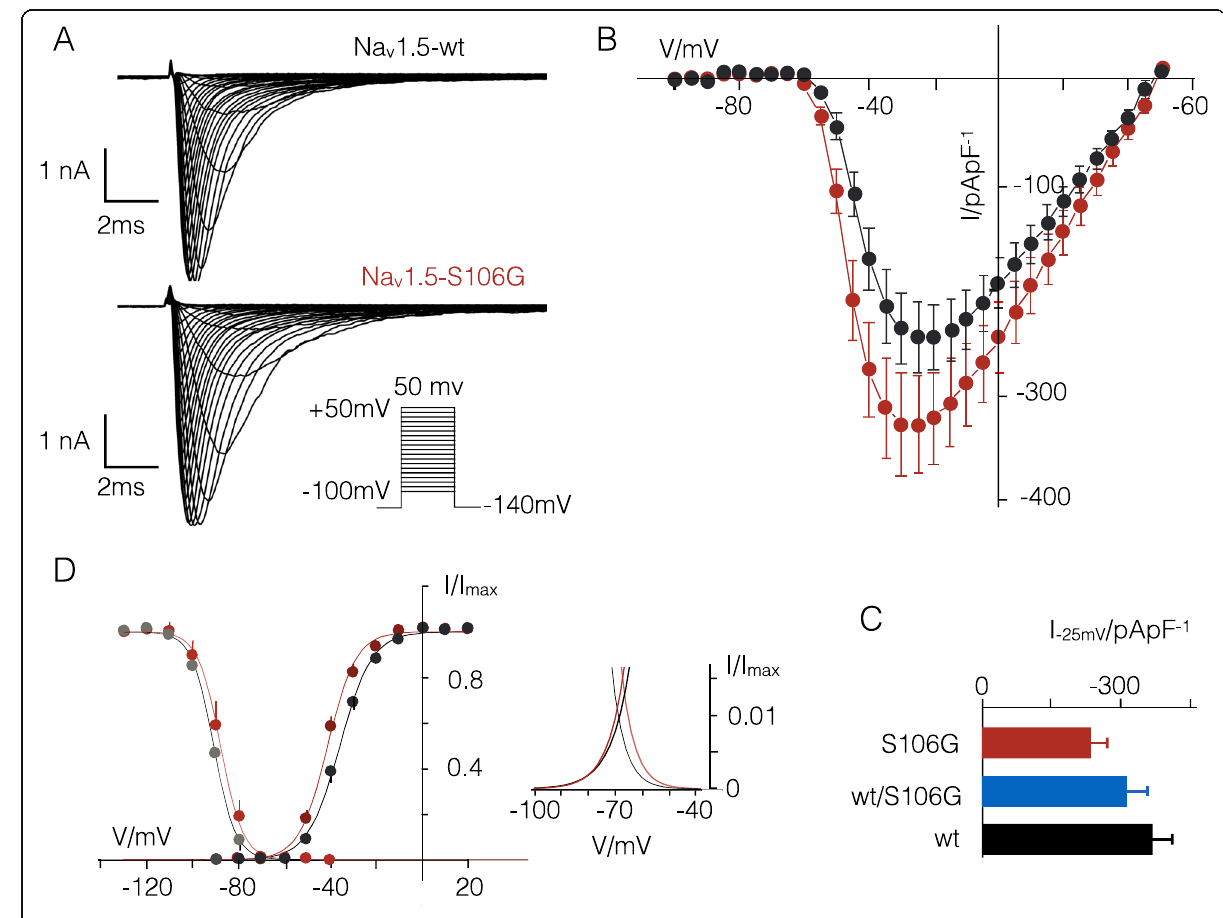
Fig. 3 Na v 1.5 S106G results in gain of function. a Typical Na + currents in HEK293 cells transiently expressing Na V 1.5 WT (top) or Na V 1.5-S106G mutant (down). Currents were elicited by clamping cells from holding voltage ( − 140 mV, 100 mS) to test voltages (between + 50 mV and − 100 mV, 100 ms) and back to post clamp voltage ( − 140 mV, 100 ms). b Mean current density/voltage relationships (±SE) from cells transfected with WT (black, n = 9) or S106G mutant (red, n = 8). c Peak currents at − 25 mV from ( b ) for WT (black) mutant (red) and data from cells co-transfected with WT and S106G mutant (blue, n = 12). d Boltzmann fits of voltage-dependent inactivation (left) and activation (right) for Na v 1.5 WT (black/ grey) and Na v S106G mutant (red/brown). The mutation causes a positive shift in the V 1/2 value for inactivation ( − 88.2 ± 0.8 mV versus 91.5 ± 1 mV) and a negative shift of the V1/2 value for activation ( − 45.3 ± 0.9 mV versus − 39.9 ± 0.8 mV). The P value for a difference between V 1/2 values of the WT and mutant < 0.05. Inset: estimated window currents for WT and mutant from ( b ). The colors of the line correspond to those in ( c